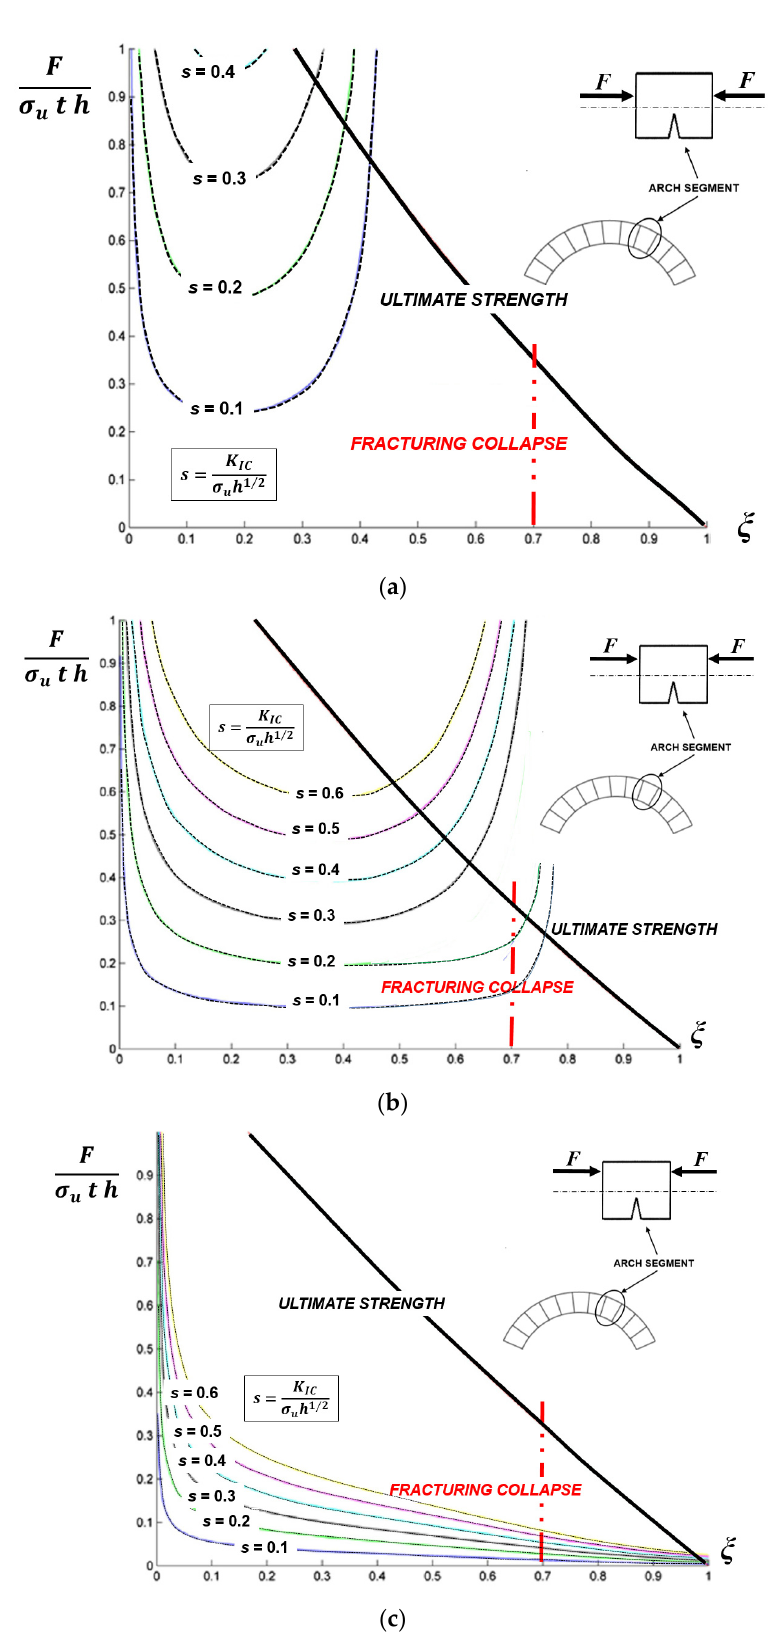
Figure 6. Scale effects in masonry arch structures: Dimensionless load of brittle crack propagation versus normalized crack depth, ξ , for e / h = 0.15 ( a ); e / h = 0.20 ( b ); e / h = 0.35 ( c ).